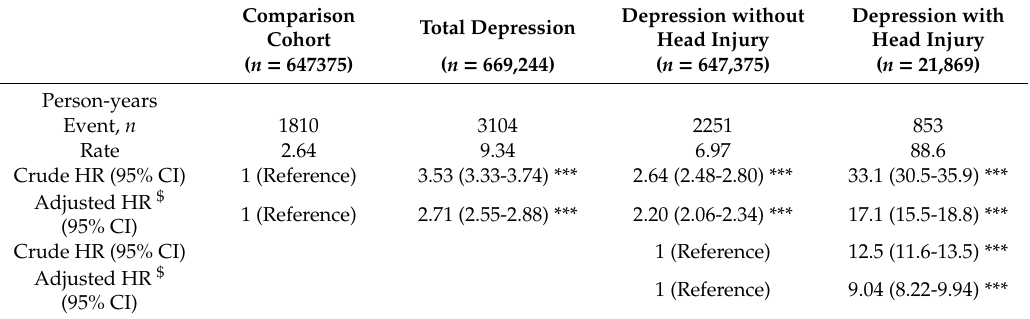
Table 5. Incidences and hazard ratios of suicidal drug overdose (per 10,000 person-years) in patients with depression with or without head injury using the Cox